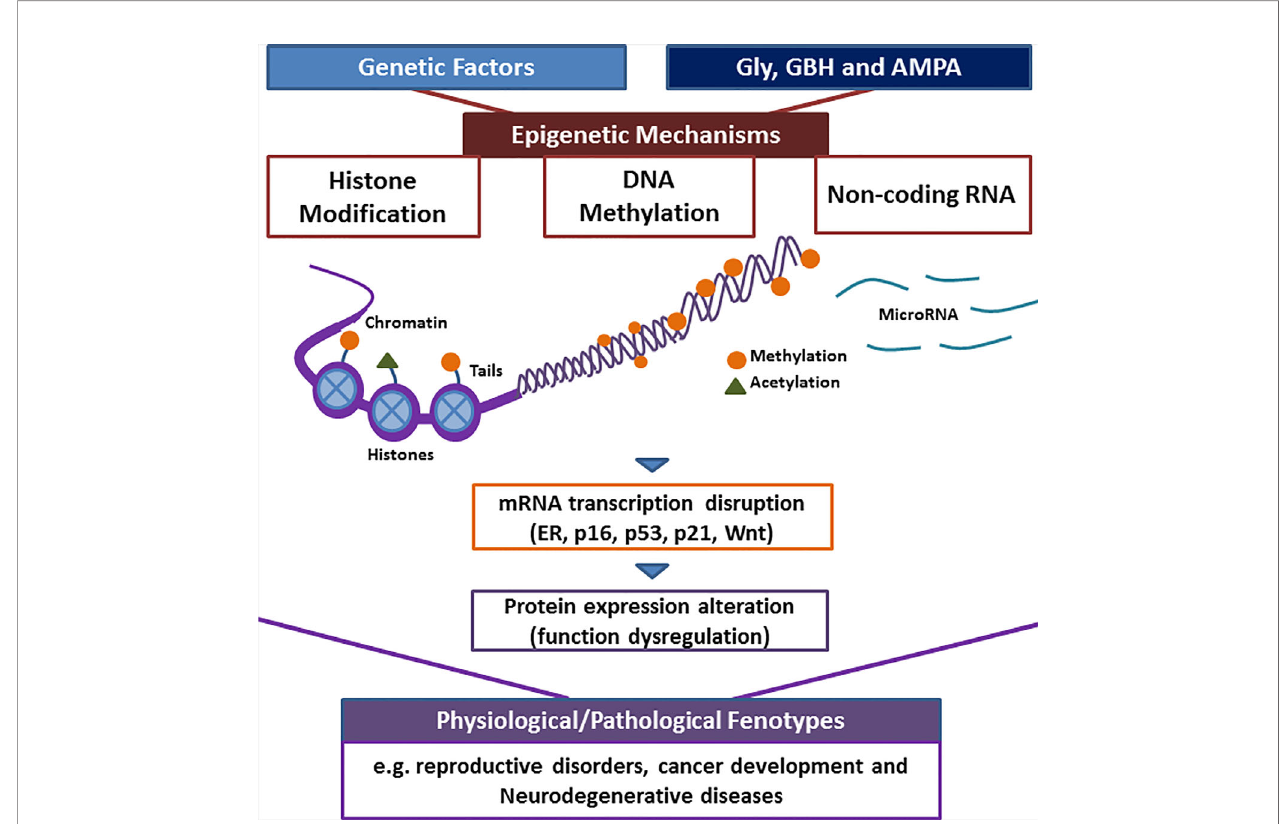
FIGURE 1 | Possible mechanism that links the exposure to herbicides, the epigenome modi fi cation and the observed phenotypes. Chromosomes are composed of chromatin wrapped around proteins called histone; modi fi cations of histone tails and DNA methylation control transcriptional access to DNA. Non-coding RNAs also regulate transcription. The exposure of herbicides, such as glyposhate (Gly), glyphosate-based herbicides (GBH) and, its main metabolite, (aminomethyl) phosphonic acid (AMPA) could alter the epigenome and could produce the silencing/activating of numerous genes, including estrogen receptor (ER), p16, p21, p53, and Wnt. This could result in the disruption of physiological functions and the promotion of health